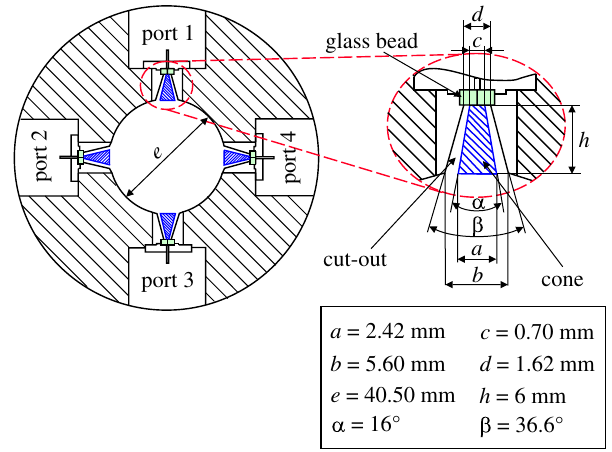
FIG. 1. Cross section of the cone-shaped pickup with the